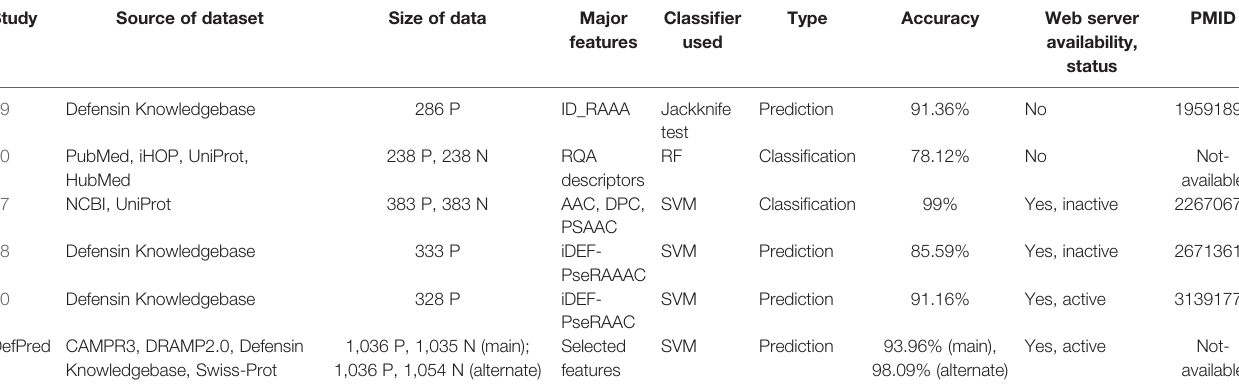
TABLE 3 | Describing the major components of the existing methods and DefPred such as the source of the dataset, size of data, major features, type, and